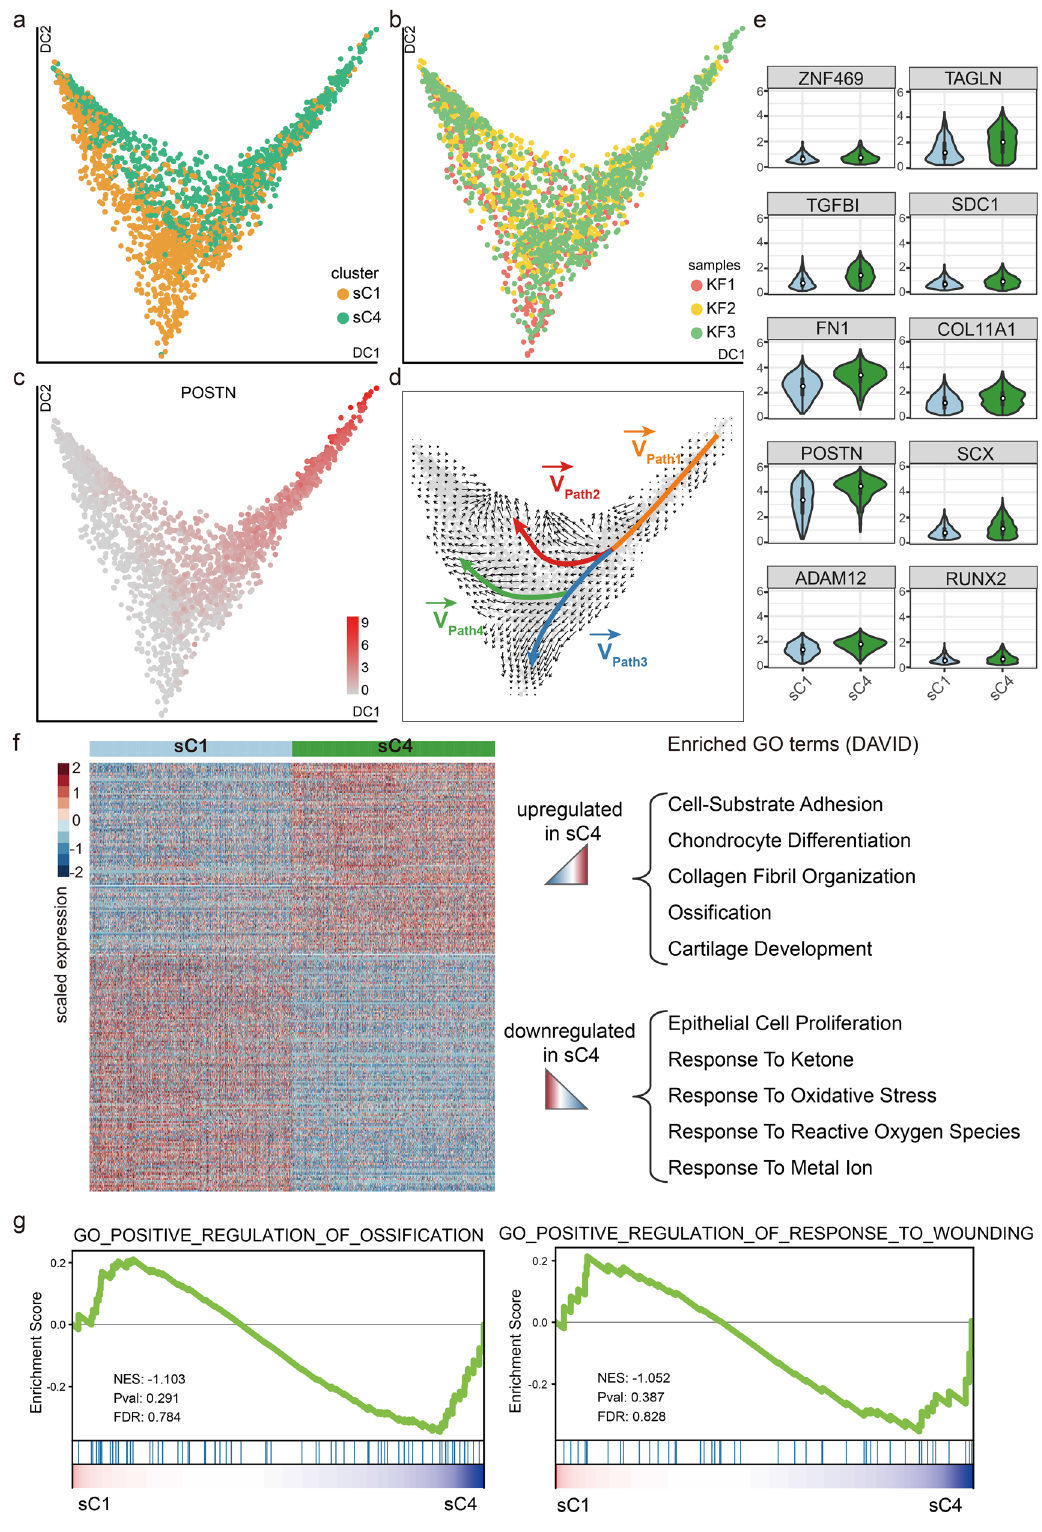
Gene sets enrichment analysis . Gene Ontology 46 functional enrichment (over- representation) of DEGs at P <0.05 was analyzed using a R package clusterPro fi ler v3.12.0 47 . Gene Set Enrichment Analysis (GSEA) also conducted using GSEA desktop software, and collected gene sets and molecular signatures were obtained from the Molecular Signatures Database 48 . Normalized enrichment scores were acquired using gene set permutations 1000 times, and a cutoff P -value of 0.05 was used to fi lter the signi fi cant enrichment